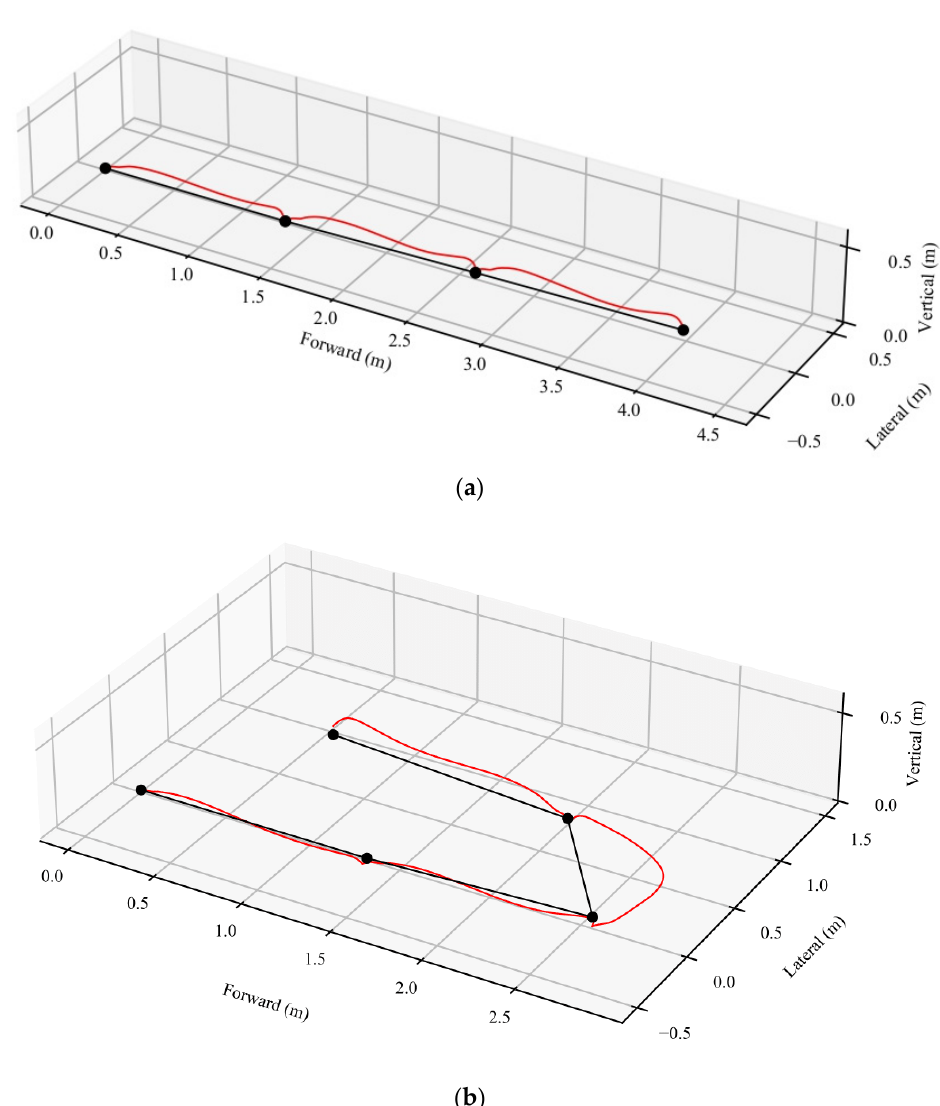
Figure 2. Example of walk trajectory used to calculate the total distance walked on a straight path ( a ) and with addition of a turn ( b ). The black dots show the position of the foot during the foot flat periods, the red trace shows the three-dimensional trajectory of the foot during each stride, and the black line segments show the horizontal distance traveled during each of the three strides. The total walk distance is then simply computed as the sum of walk distances for each stride.